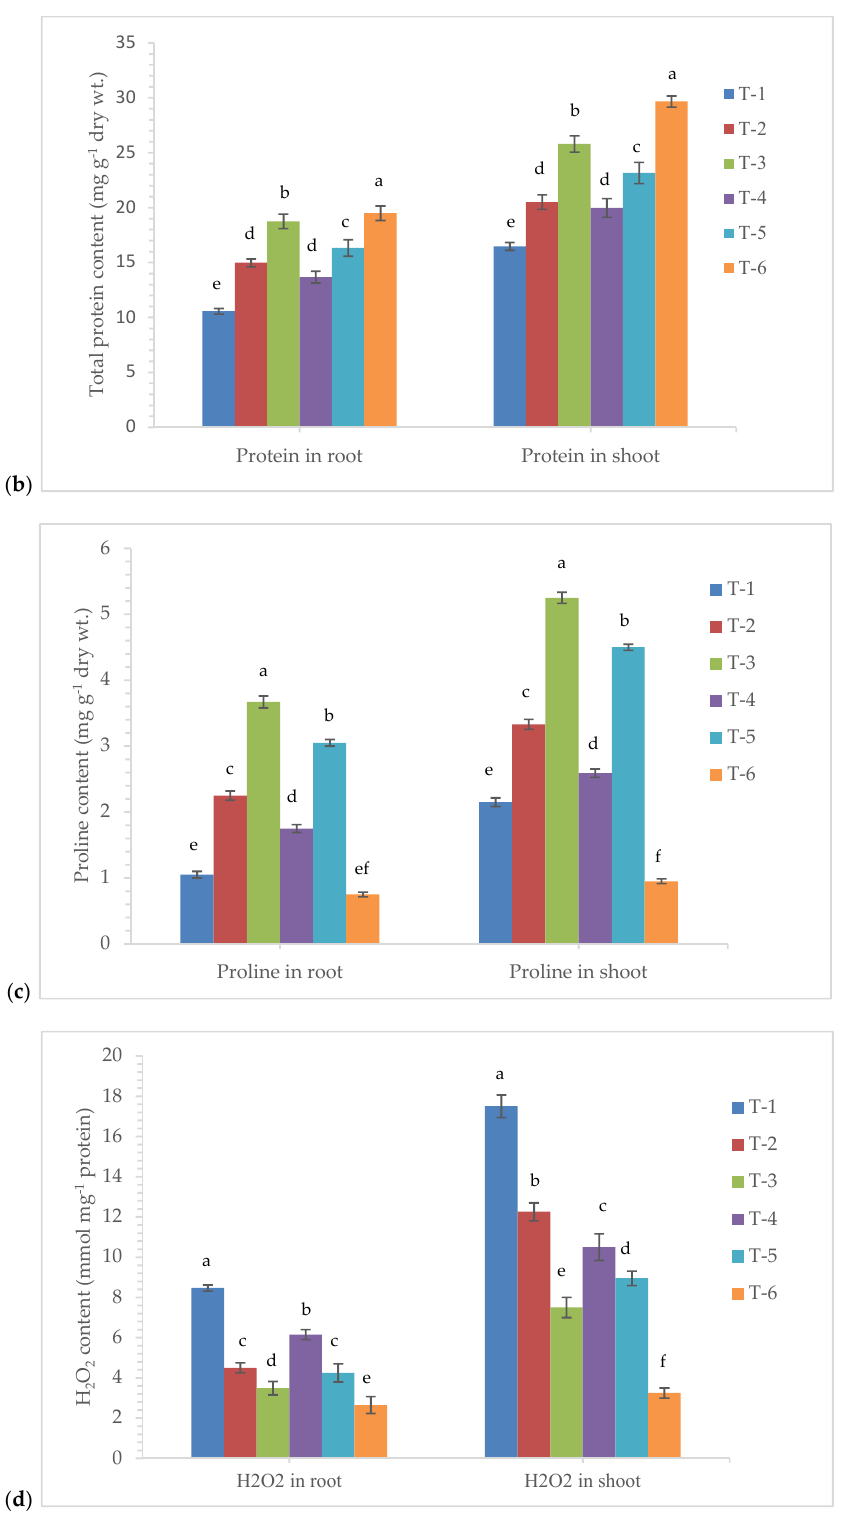
Figure 4. Effects of seed bio-priming and other treatments on ( a ) total soluble sugar content, ( b ) total protein content, ( c ) total proline, and ( d ) H 2 O 2 content in maize roots and shoot at 7 DAPI under nethouse condition. Treatments were: T 1 -plants inoculated with R. solani alone; T 2 - R. solani + seed bio-primed with P. aeruginosa MF-30; T 3 - R. solani + seed bio-primed with P. aeruginosa MF-30 + foliar spray of MF-30; T 4 - R. solani + foliar spray of culture filtrate of MF-30; T 5 - R. solani + seed bio-primed with P. aeruginosa MF-30 + foliar spray of culture filtrate of MF-30; T 6 -Control (untreated). Data are mean ± SEM ( n =